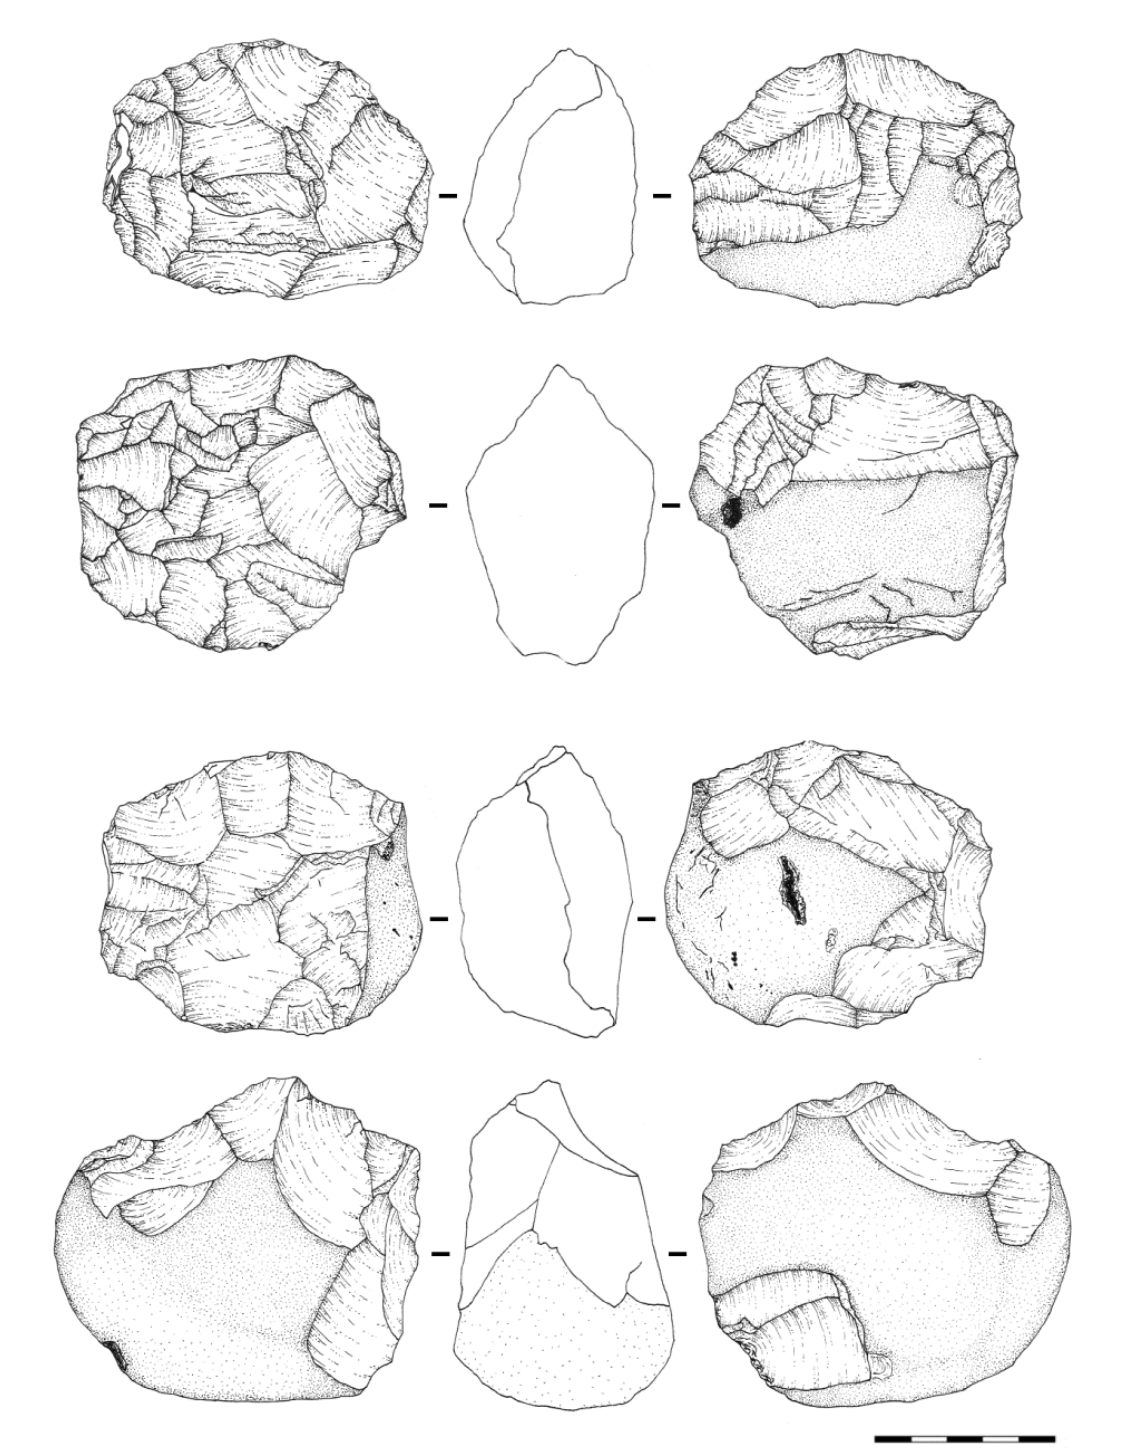
Figure 10. Discoid cores sensu largo (partial) of Camillo (drawings: Institut Català de Paleoecologia Humana y Evolució Social). Scale bar: 5